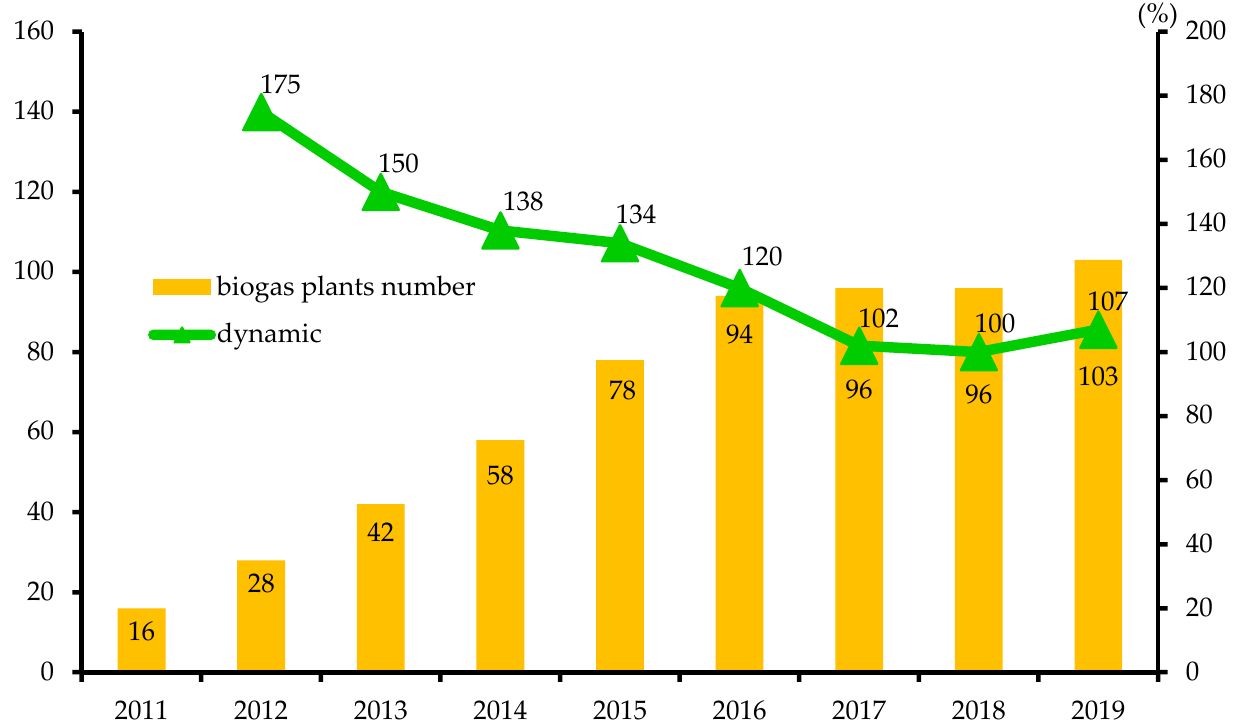
Figure 1. Biogas plants number and the dynamics of their creation. Source: based on Agricultural Market Agency/National Agricultural Support Center data